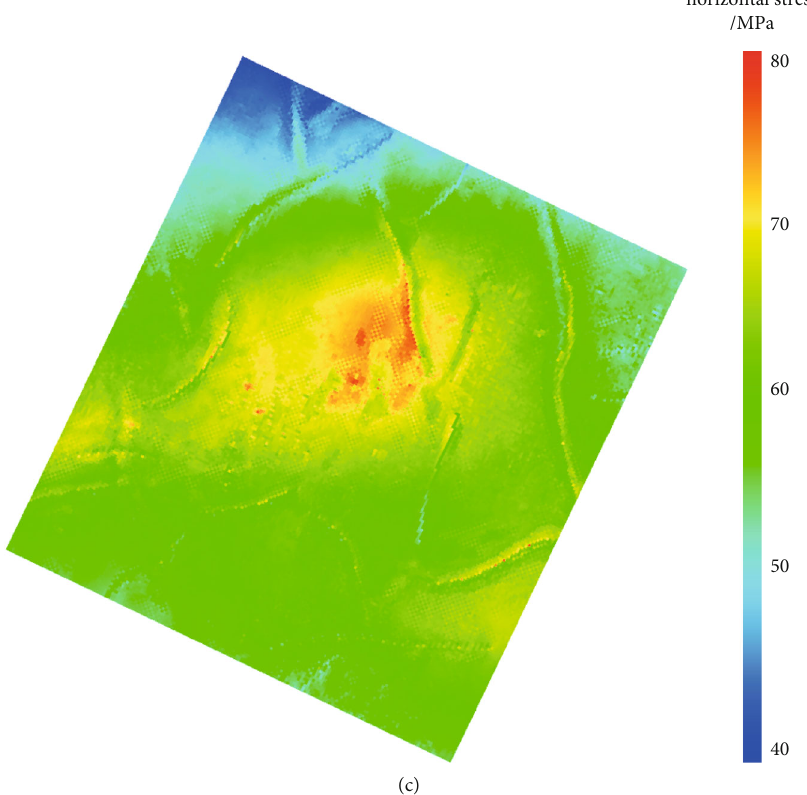
Figure 6: The 3D in-situ stress fi eld of the Ning209 block: (a) the overburden stress, (b) the maximum horizontal stress, and (c) the minimum horizontal stress.